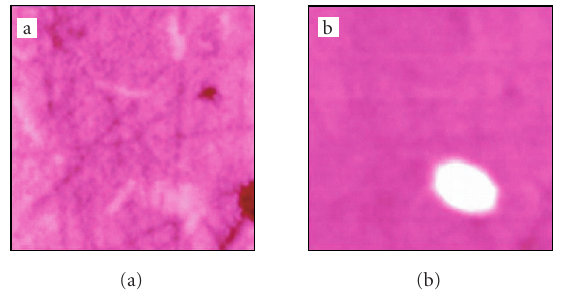
Figure 12: Local resonant RAMAN SNOM spectrum of the pyrite geode of Figure 11 (pyrite 145 scanlines) in dolomite; the spectrum is flattened and a baseline subtraction has been